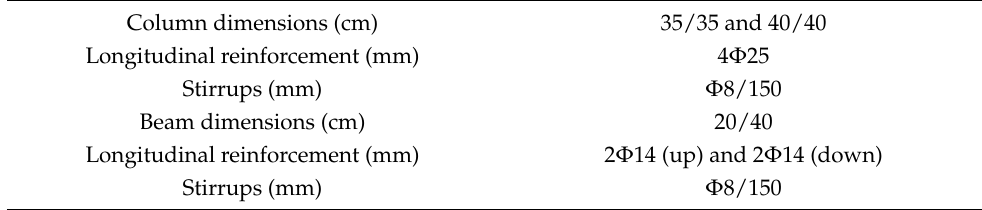
Table 1. Sections and the steel reinforcement of the two-storey RC building.